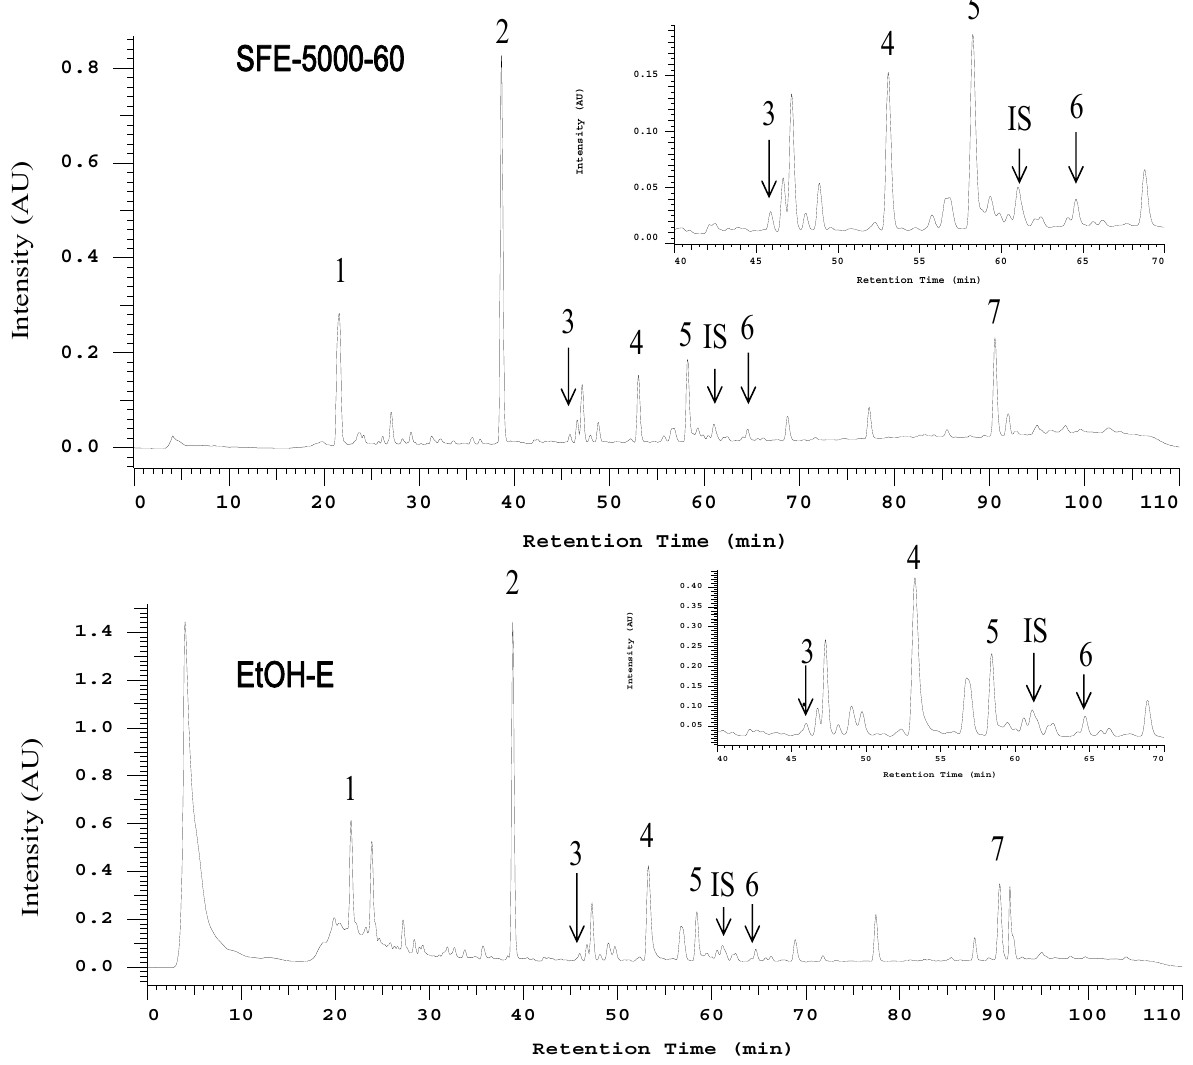
Figure 2. The HPLC-UV chromatograms (detected at 254 nm) of S-5000-60 and EtOH-E extracts of solid cultured mycelial Antrodia cinnamomea. Peak numbers are referred to Table